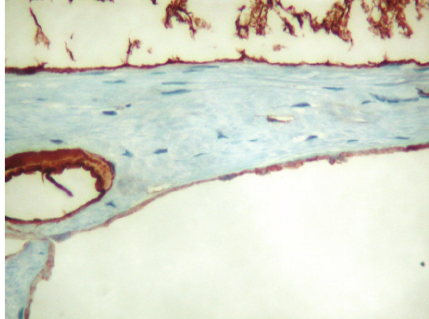
Figure 5: showing cystic cell lining positive for factor VIII confirm- ing endothelial cell origin (immunohistochemistry stained